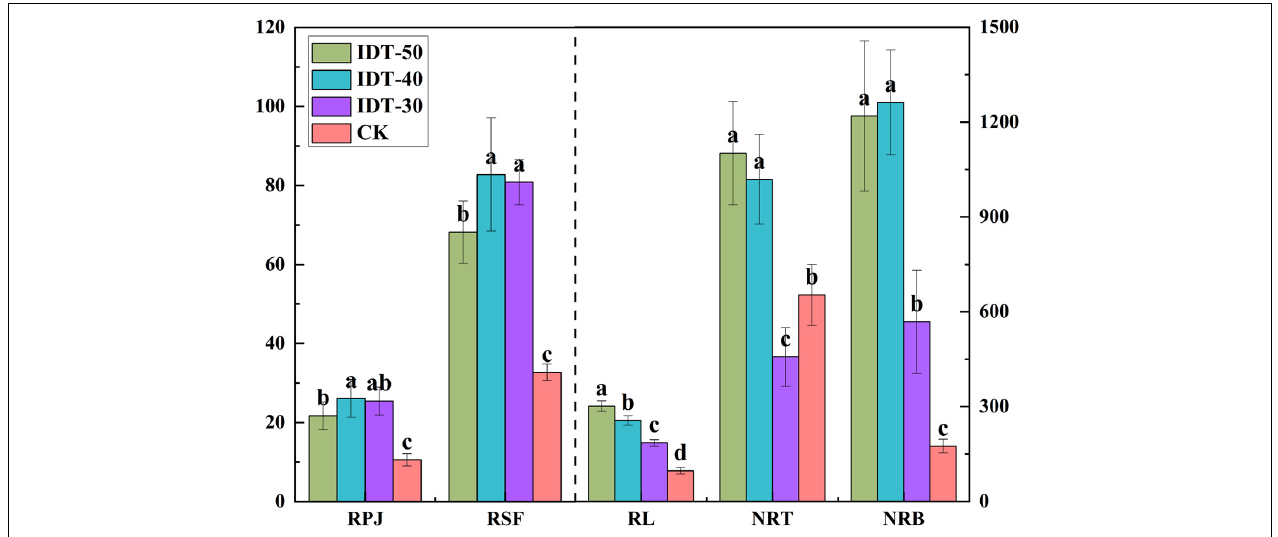
FIGURE 1 | One-way ANOVA of root system architecture (RSA) traits among treatments. Different letters indicate statistically significant differences among treatments ( p < 0.05). RPJ, root projection area (cm 2 ); RSF, root surface area (cm 2 ); RL, root length (cm); NRT, number of root tip; NRB, number of root branches.